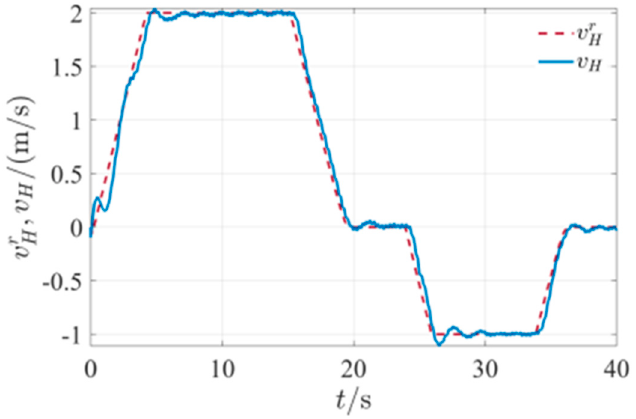
Figure 17. The evolution of altitude-direction velocity as a function of